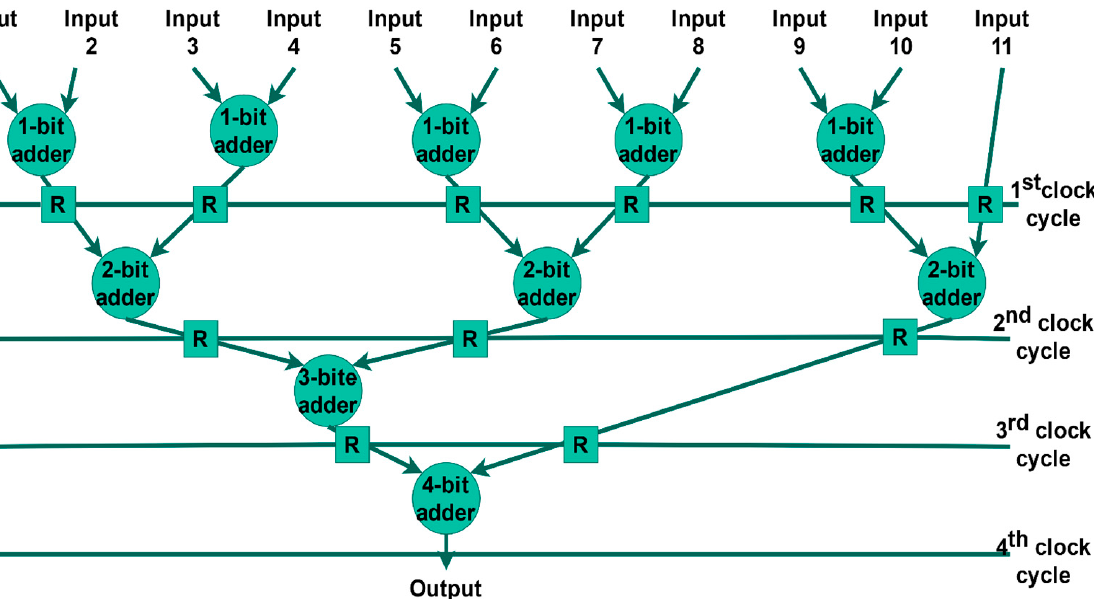
additions (either ceil ( n ) or floor 2 i 2 i